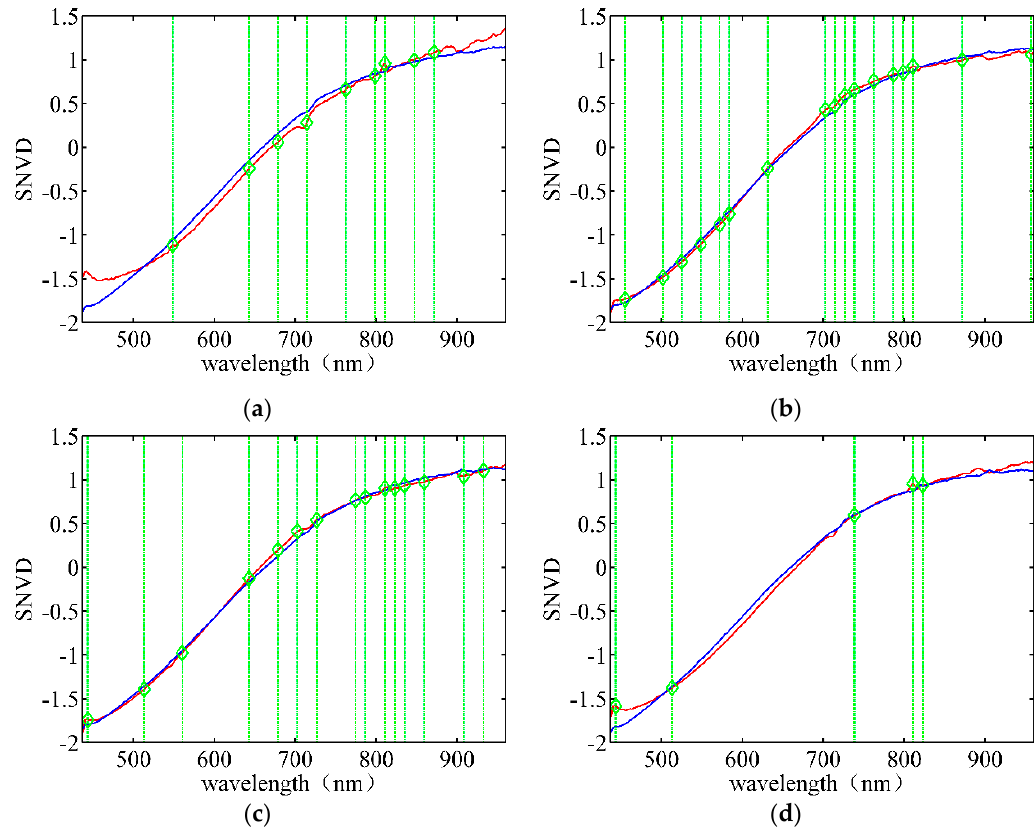
Figure 7. Wavelength band selection using SNV data for different rice varieties under the optimal λ . ( a ) Huguangxiang; ( b ) Xiangwan Japonica; ( c ) Huanghuazhan; ( d ) Japonica 530.